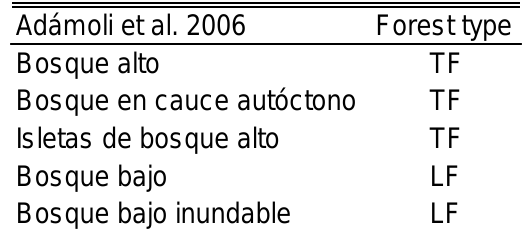
Table A1.1. Correspondences between forest categories in the base forest map of 2006, and those used for the application of Formosa Law. TF: Tall forest, LF: Low